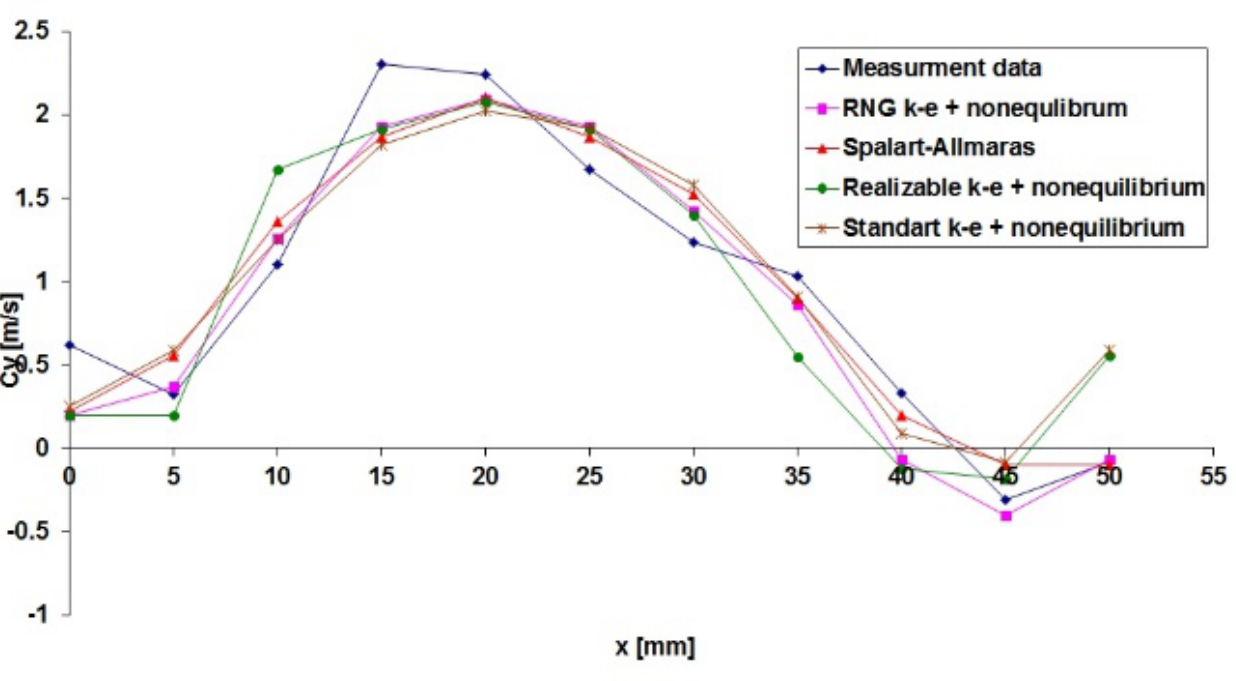
Figure 14. Comparison of the course of the cx, cy velocity components for Line 2.